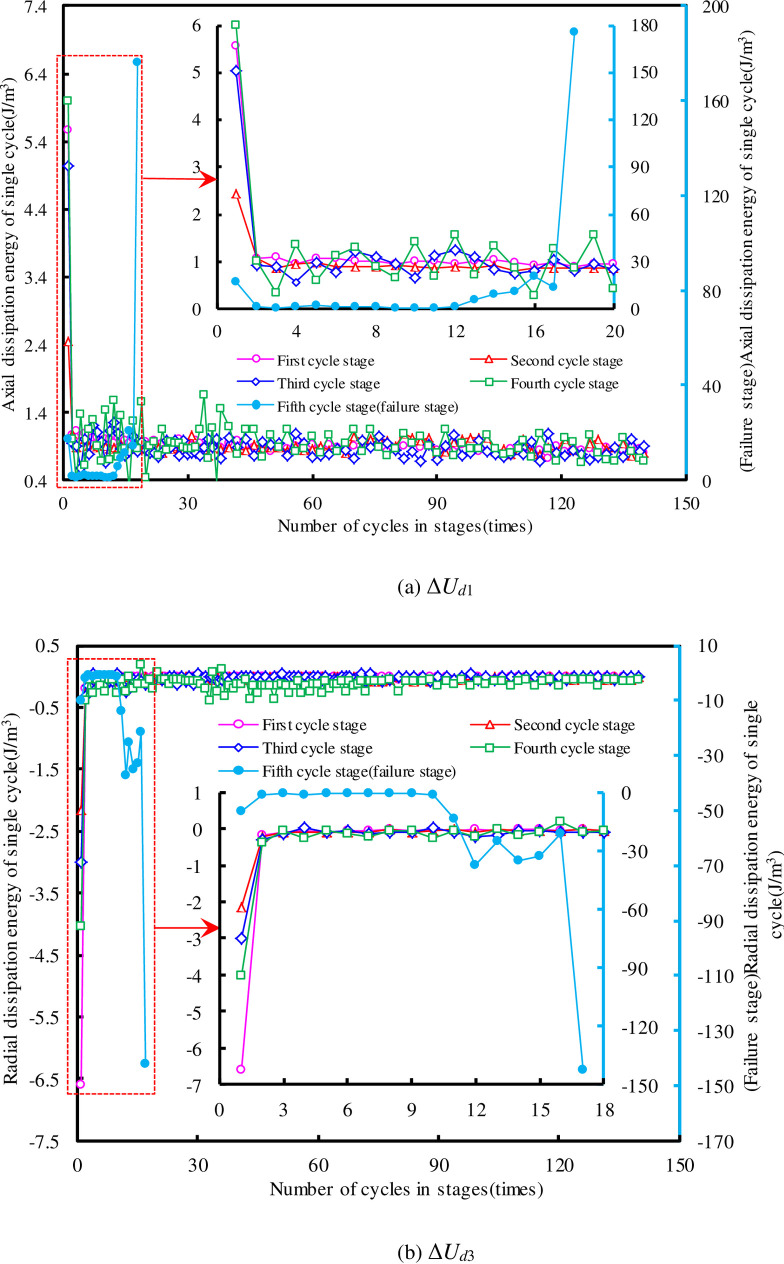
The curve of ΔUd in the SS-2 at different cycle stages.